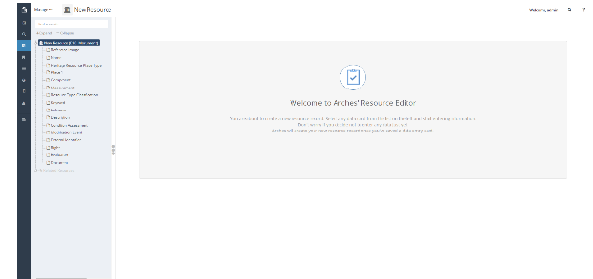
Figure 10. Display chart of home page connection function